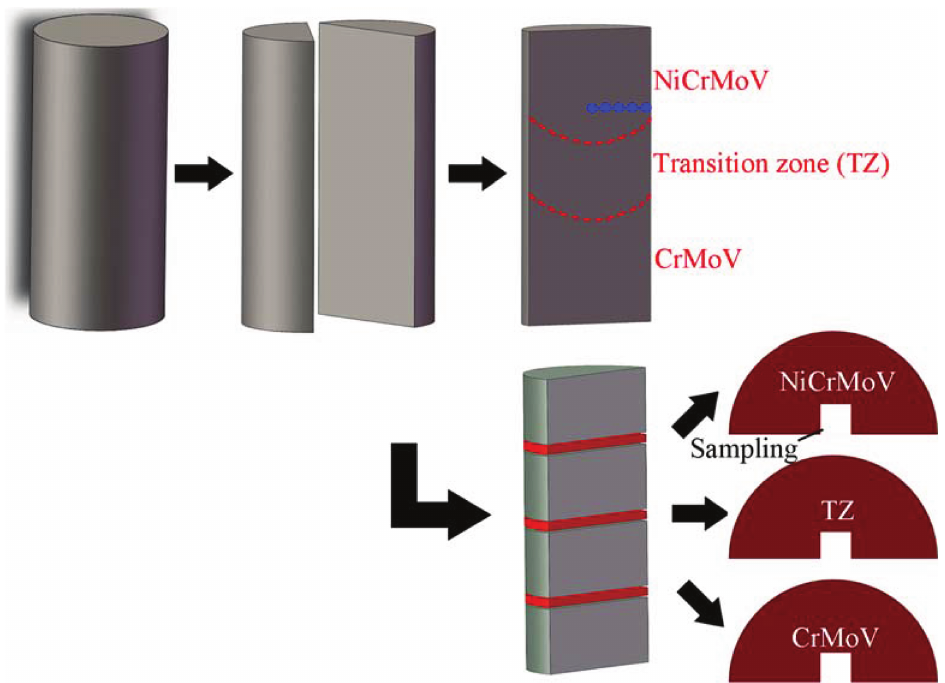
Figure 1: Schematic drawing of the dissection of the ESR ingot.